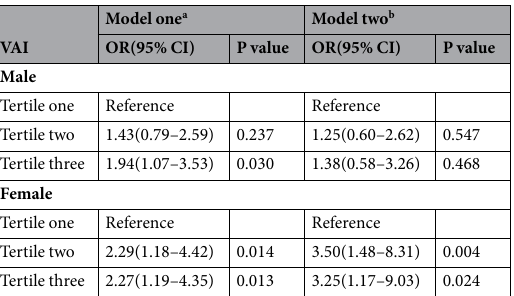
Table 3. Relationship between VAI and ICAS in different genders. a Adjusted for age; b Based on Model one, Model two was further adjusted for diabetes mellitus, hypertension, coronary heart disease, previous stroke, current smoking, daily drinking, body mass index, HDL-C, fasting plasma glucose, waist circumference, systolic blood pressure and diastolic blood pressure. HDL-C, high density lipoprotein cholesterol; VAI, visceral adiposity index; ICAS, intracranial atherosclerotic stenosis.